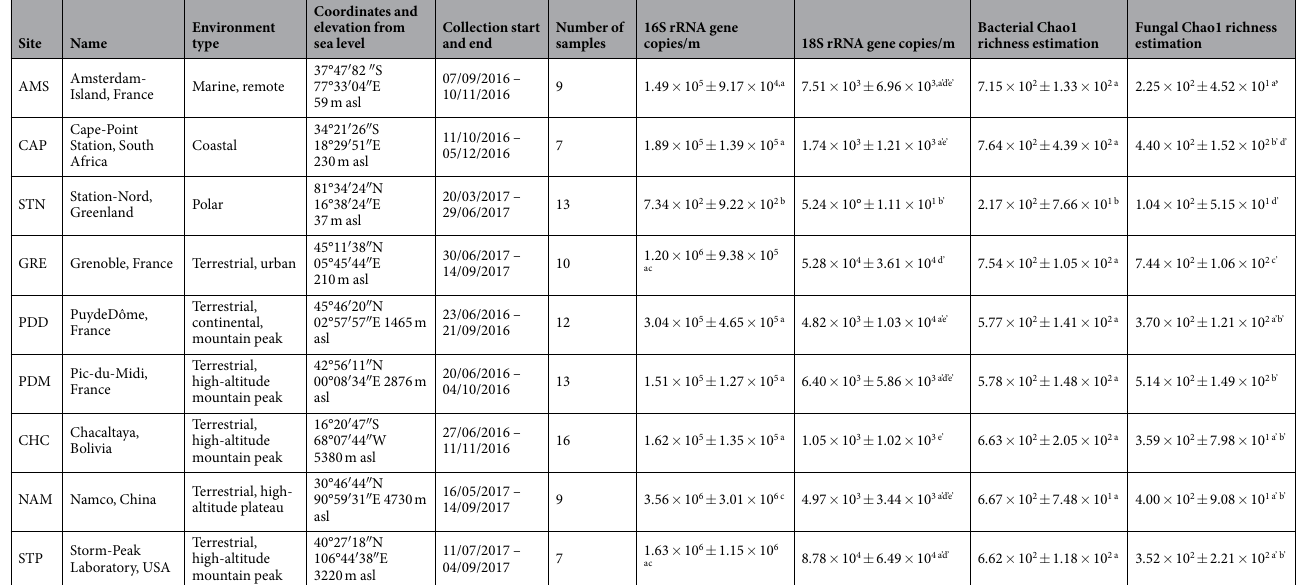
Table 1. Summary of bacterial and fungal abundances and bacterial (genus level) and fungal (species level) Chao1 richness estimations averaged per site and associated to a standard deviation. Reference letters indicate the group membership based on Tukey’s HSD post hoc tests. The environment type, coordinates, elevation from sea level, collection start and end per site and the number of samples collected per site are shown. The 16S rRNA gene qPCR data was previously published in Dommergue et al., (2019) 27